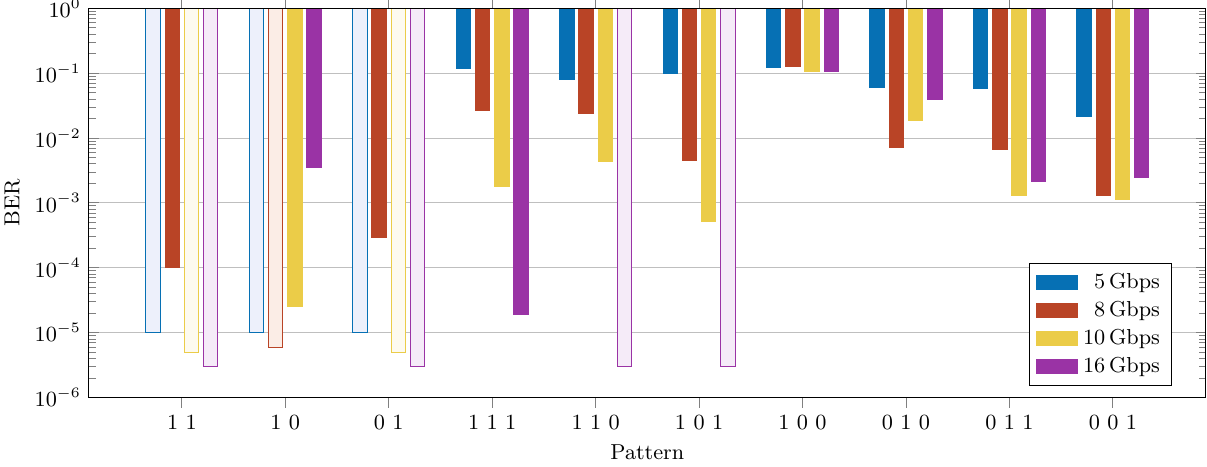
Figure 3. Measured BER as a function of the target symbol for the pattern recognition task. The different colored bars refer to the different bit-rates reported in the inset. Transparent bars refer to a BER value equal to the statistical limit (i.e., error free calculation). This value is 10 − 5 , 6 × 10 − 6 , 5 × 10 − 6 , 3 × 10 − 6 for a bit-rate of 5, 8, 10, 16 Gbps,